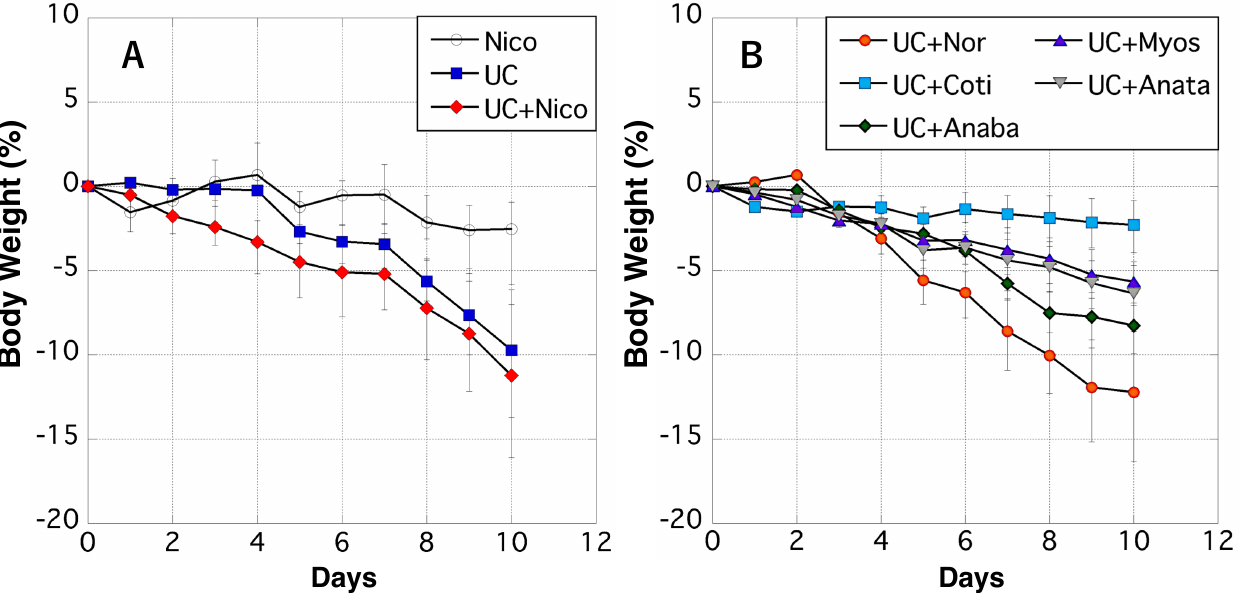
Figure 2. Changes in the body weight of rats. ( A ) The y -axis indicates the percentage fluctuation in the body weight of the Nico (white circle), UC (blue square), and UC + Nico (red diamond) groups after initiating the experiment. ( B ) The y -axis shows the percentage fluctuation in the body weight of the UC + Nor (yellow circle), UC + Coti (light blue square), UC + Anaba (green diamond), UC + Myos (purple triangle), and UC + Anata (gray inverted triangle) groups after initiating the experiment. ( A , B ) The x -axis indicates the number of days after initiating the experiment. Data values are presented as the median ± max/min. Anaba, anabasine; Anata, anatabine; Coti, cotinine; Myos, myosmine; Nico, nicotine; Nor, nornicotine; and UC, ulcerative